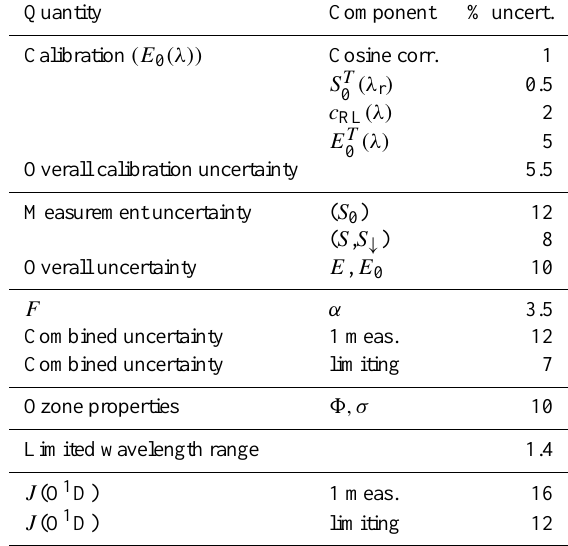
Table A1. Summary of the percentage uncertainties ( 1 σ) in deter- mining the irradiance, the estimation of the spectral actinic flux and J (O 1 D). The “limiting” uncertainties are calculated for estimates based on averaging numerous measurements. In this case the mea- surement uncertainty is no longer